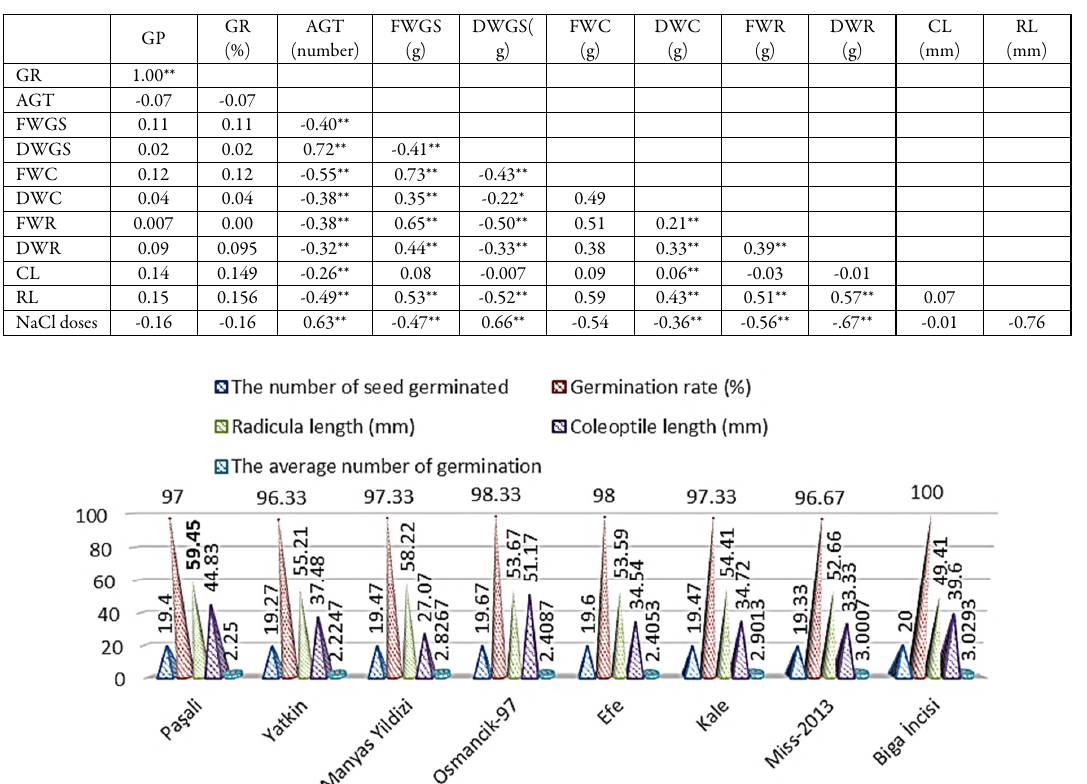
Figure 1. Different NaCl levels effect on the number of seed germinate (number), germinated rate (%), coleoptile length and radicula length (mm) and the average number of germination (number) Fresh and dry weight of coleoptile and radicula